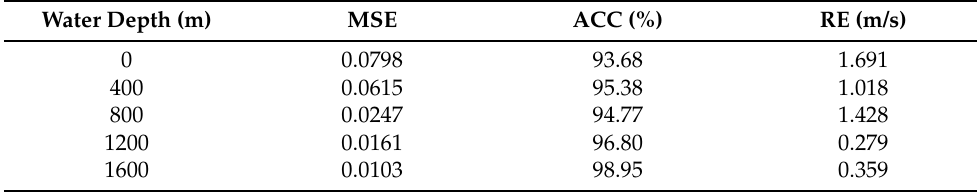
Table 3. Predicted results of different water depth in the chosen area (15.5° N–34.5° N, 160.5° W– 179.5°